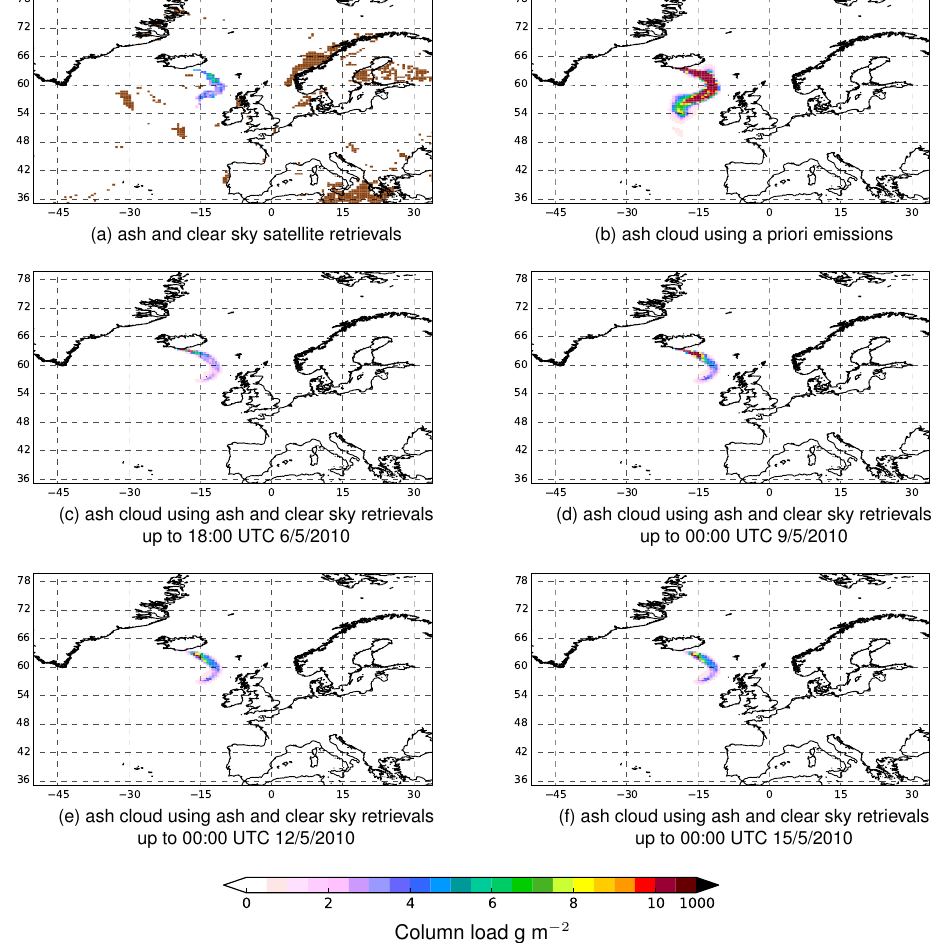
Satellite retrievals for Eyja page 546 of 546 Last Satellite Retrieval: 06/05/2010 18:00 Run Date: March 16, 2018 Run Date: March 16, 2018 Column load g m − 2 Figure 6. The Eyjafjallajökull ash cloud (column load contribution from the 1–30 µ m size range, g m − 2 ) averaged between 17:00 UTC and 18:00 UTC on 6 May 2010: ( a ) as observed by satellite (ash and clear skies, with clear skies shown in brown; none of the ash retrievals reach the brown part of the colour scale so all brown pixels are clear skies); ( b ) as predicted by NAME using the a priori emissions; and ( c – f ) as predicted by NAME using inversion emission profiles determined using the Plumes resulting from inversion source term for Eyja page 546 of 546 ash and clear sky satellite observations available up to various cut-off Last Satellite Retrieval: 06/05/2010 18:00 Run Date: March 17, 2018